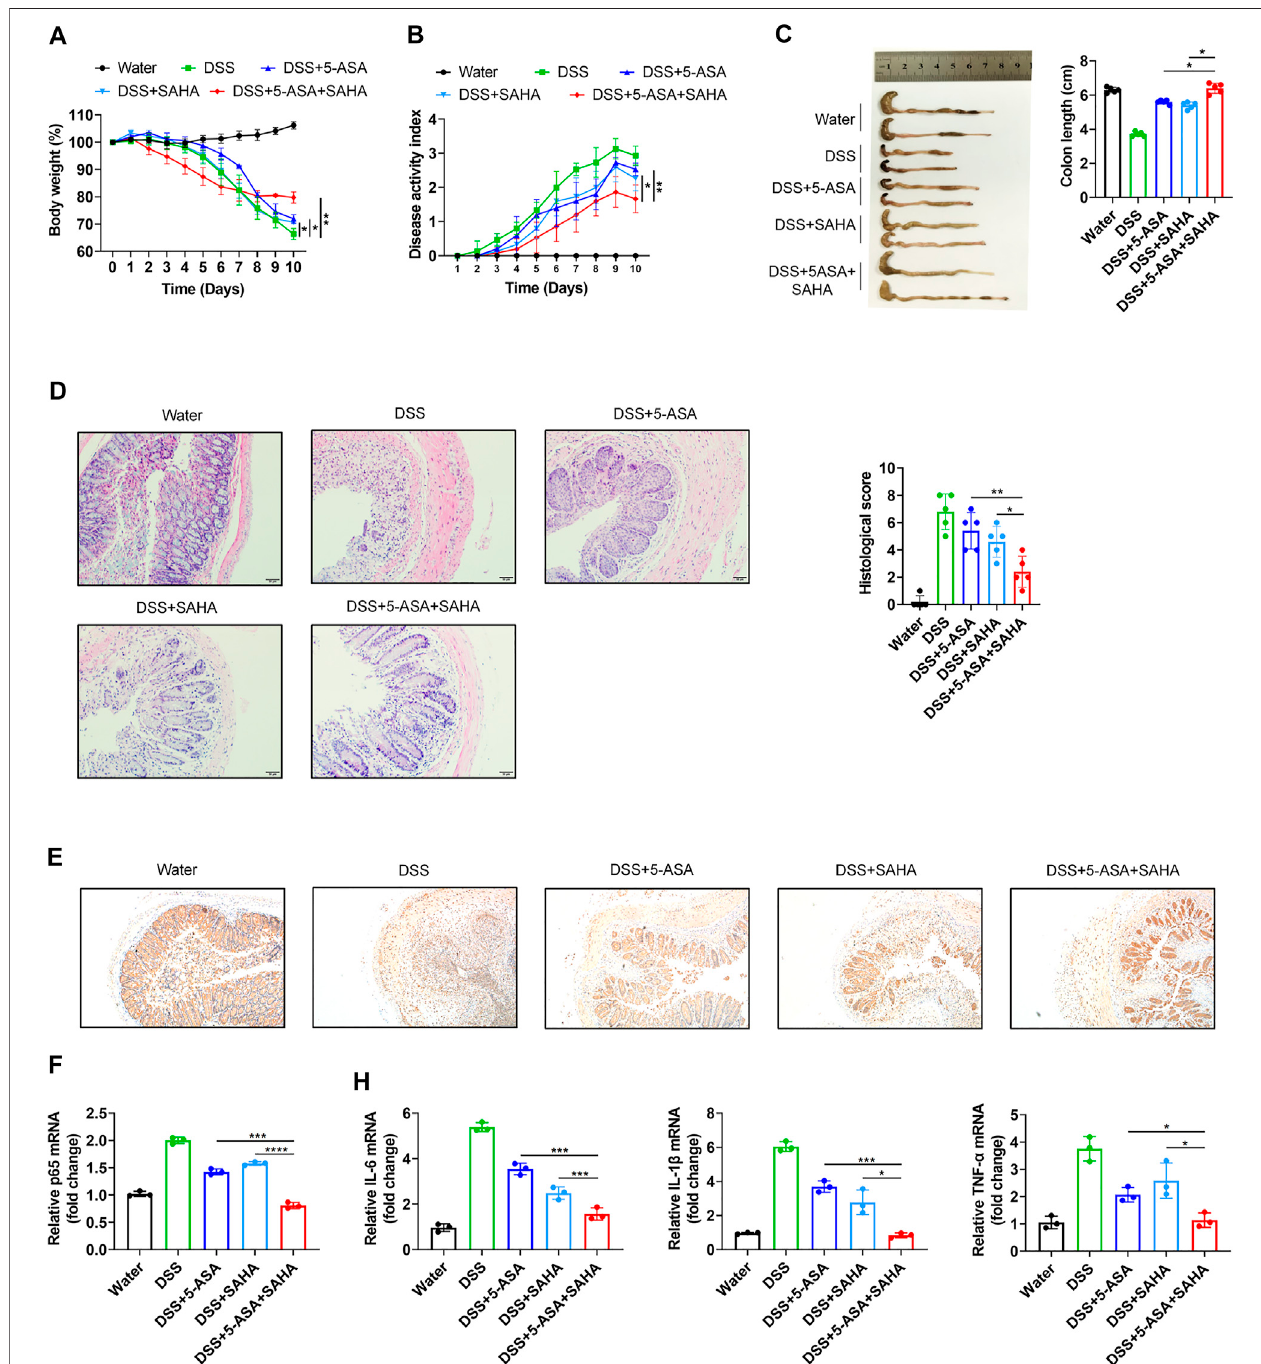
FIGURE 4 | In vitro validation of the synergetic effects of 5-ASA and SAHA on DSS-induced colitis mice. B57BL/6 mice were administered 2.5% DSS in drinking water for 7 days, followed by 3 days of water (n (cid:1) 5 per group). (A) Body weight, (B) DAI score, (C) colon length, (D) HE staining (200 × magni fi cation) and histological scores of colitis mice treated with 5-ASA (100 mg/kg/day) and SAHA (200 mg/kg/day) in combination or individually. (E) Immunohistochemistry of p65 and (F) the p65, (G) IL-6, IL-1 β , and TNF- α mRNA levels in colonic tissues. The data shown are the mean ± SD and represent three independent experiments, p values were calculated using unpaired t -test, * p < 0.05, ** p < 0.01, *** p < 0.001, ns (cid:1) not signi fi cant.